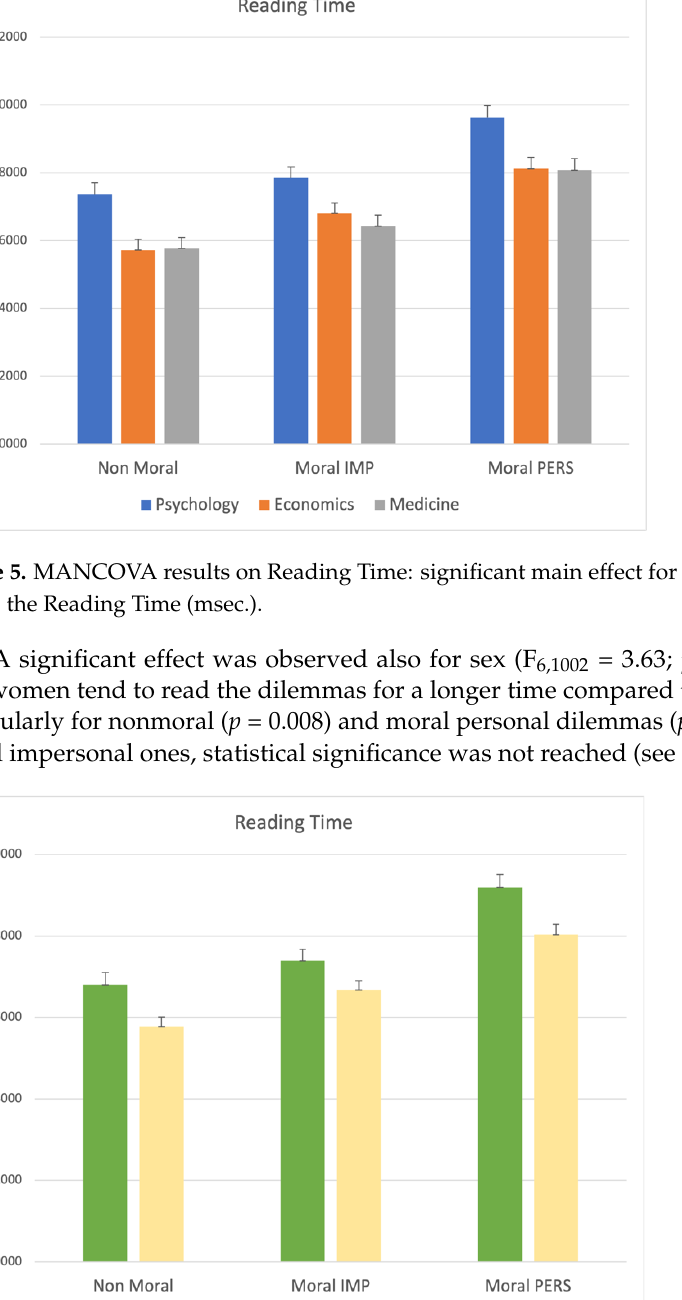
Figure 6. MANCOVA results on Reading Time: significant main effect for sex. Note: the y-axis shows the Reading Time (msec.).